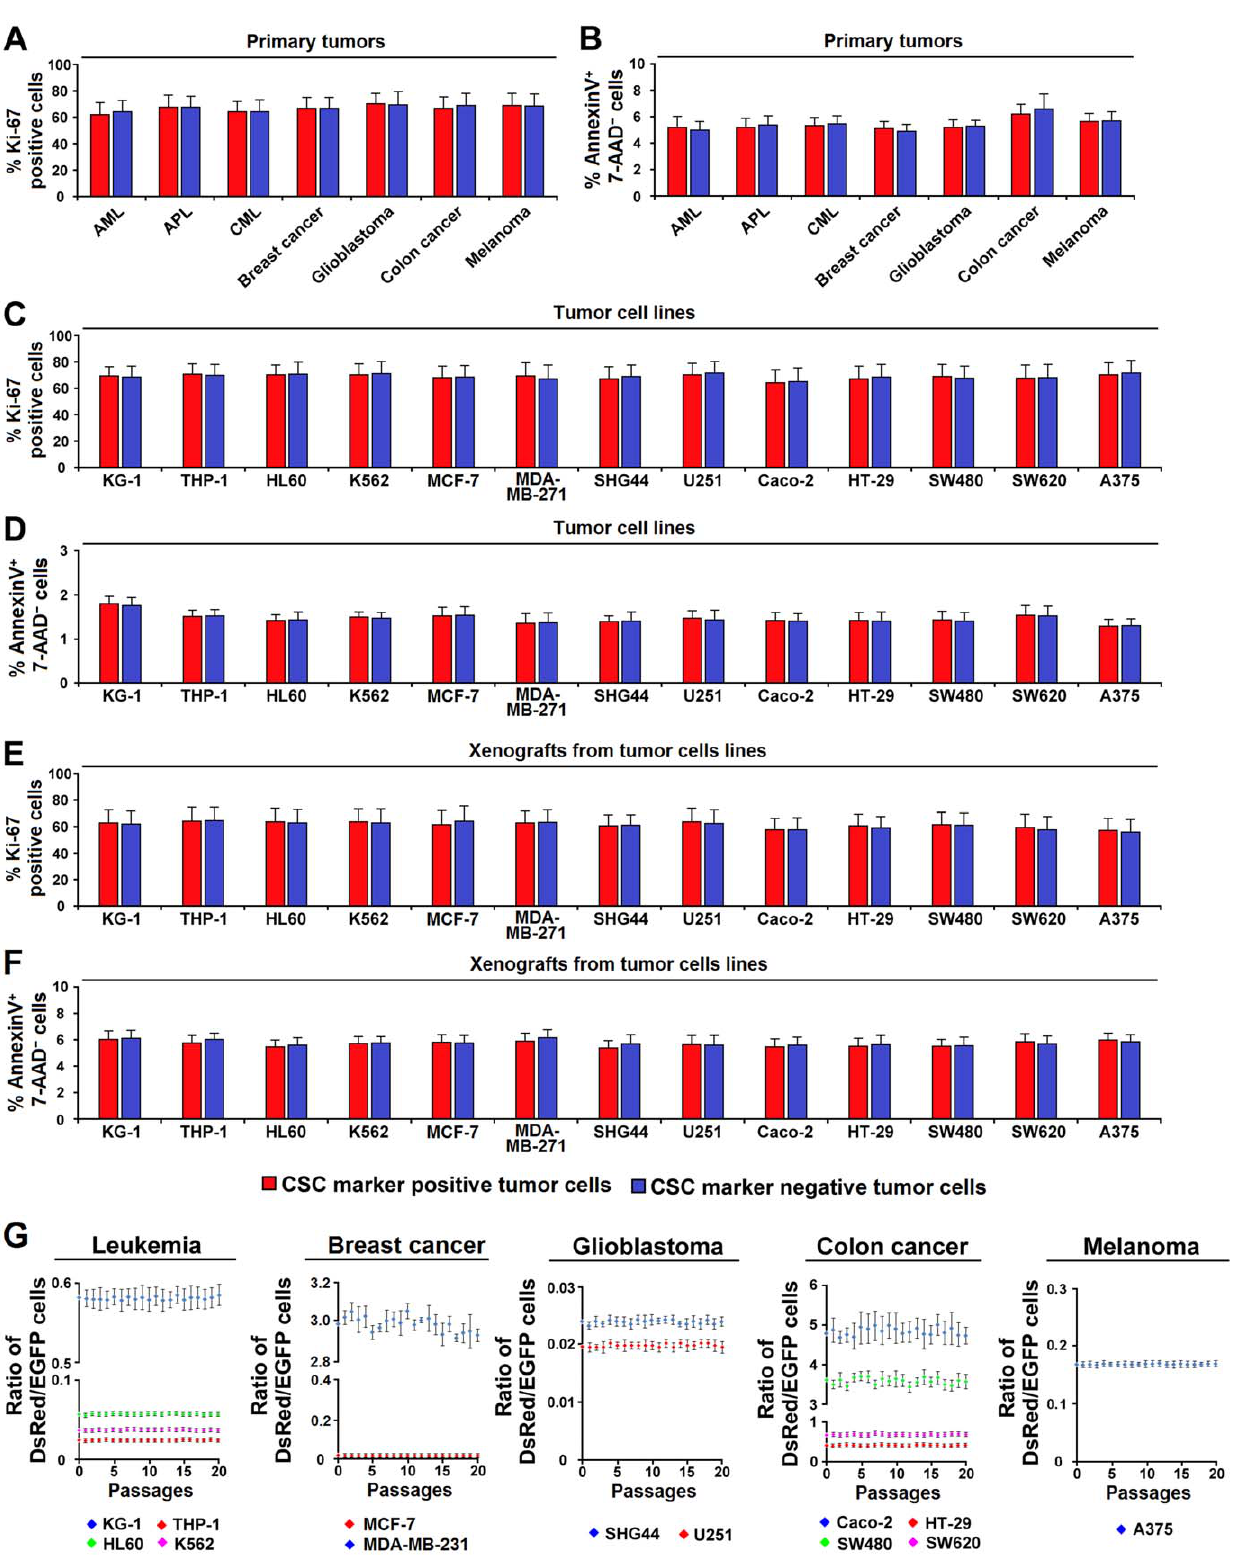
Figure 2. CSC + and CSC 2 tumor cells display similar proliferative capacity in the native state. ( A, B ) CSC marker expressing primary sample were selected to undergo Ki-67 expression and apoptosis analysis. Data represent mean 6 SEM; n=10 for each type of leukemia, n=8 for glioblastoma and for colon cancer, n=9 for breast cancer and for melanoma. ( A ) Ki-67 expression of CSC + and CSC 2 cells from human primary tumors. Single cell suspensions of human primary tumors were stained with antibodies specific to the CSC markers and Ki-67-FITC, followed by flow cytometric analysis. ( B ) Apoptosis assay of CSC + and CSC 2 cells from human primary tumors. Single cell suspensions of human primary tumors were